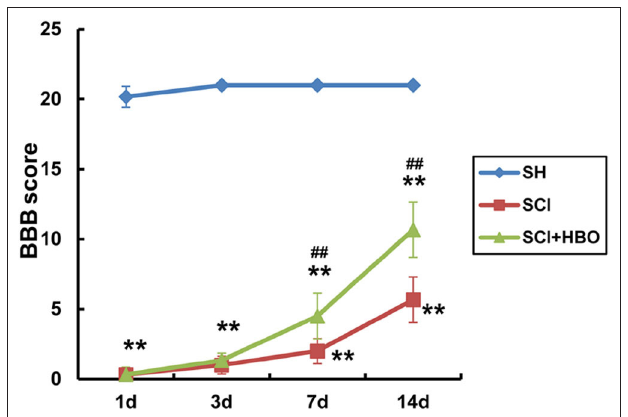
FIGURE 7 | Evaluation of locomotor function of rats using BBB score in experimental groups at destined time points. Compared with that of the SH group, the BBB score of rats significantly decreased in the SCI and SCI + HBO groups at all destined time points (** P < 0.01); HBO treatment significantly increased the BBB score compared with the SCI group on days 7 and 14 postoperatively ( ## P < 0.01). BBB, Basso–Beattie–Bresnahan; SH, sham operation; SCI, spinal cord injury; HBO, hyperbaric oxygen.